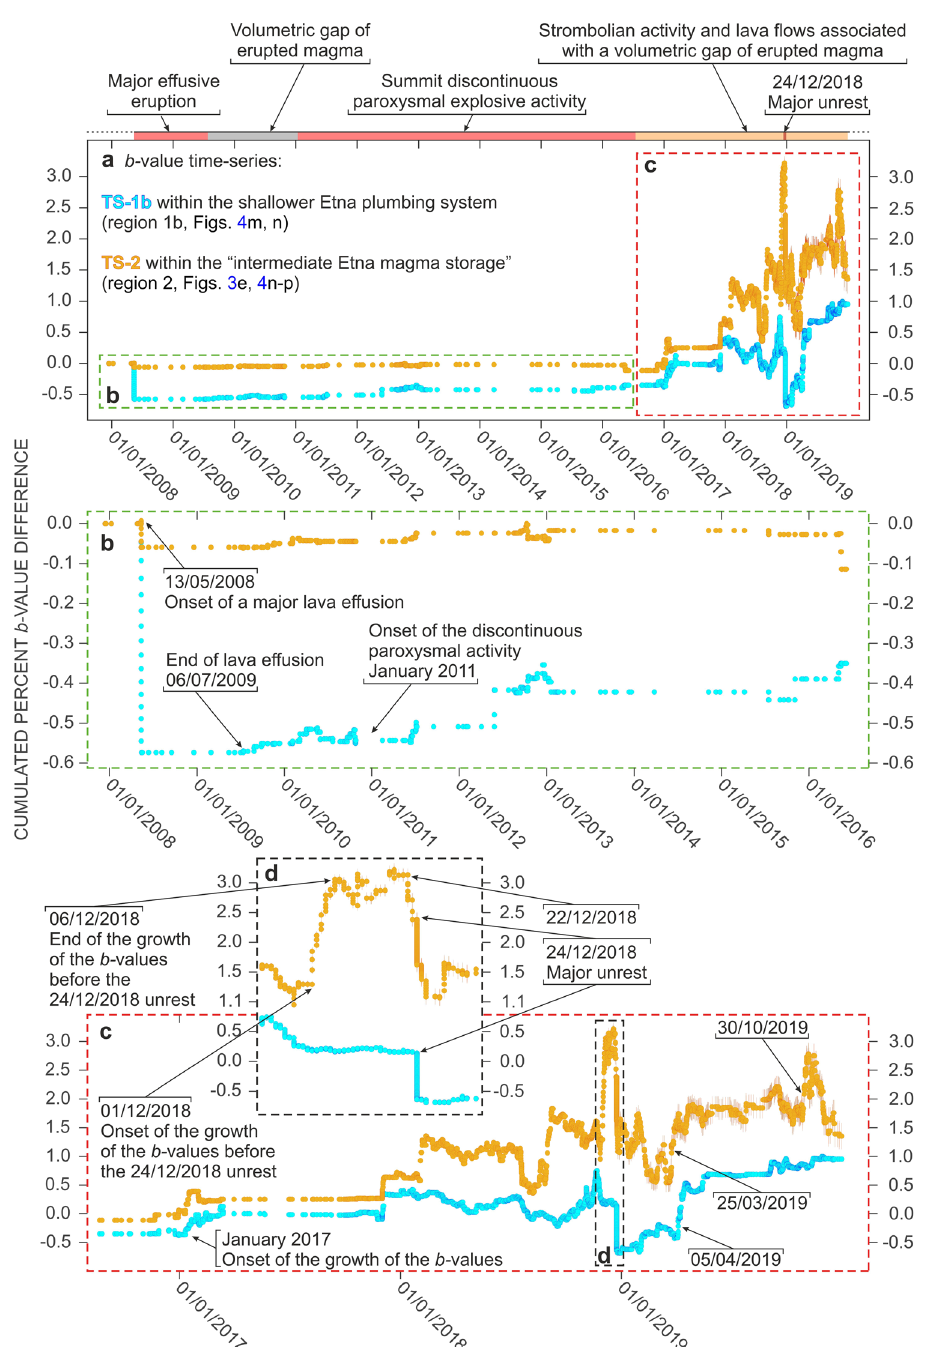
Fig. 5 b -value time series. a Time series of the b- value calculated within regions 1b (TS-1b) and 2 (TS-2), reported in Figs. 3e and 4m – p, considering the whole 2005 – 2019 seismic catalogue; the minimum conditions for reliable computation (see “ Methods ” ) were achieved only at the end of 2007. b Same as a but zoomed up to the fi rst half of 2016. c Same as a but zoomed from the second half of 2016 to 2019. d Zoomed time series on the 24 December 2018 major unrest phase. Vertical bars indicate the